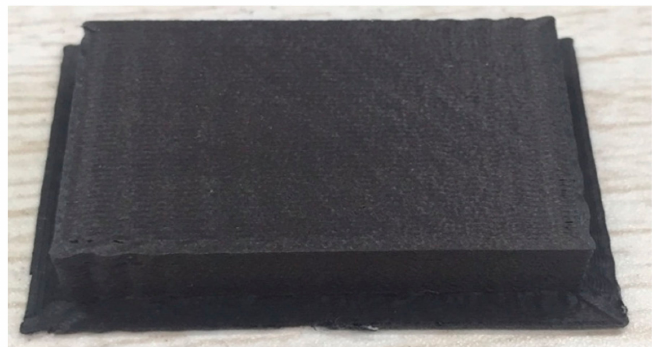
Figure 4. Composite specimen processed by fused deposition modeling (FDM).